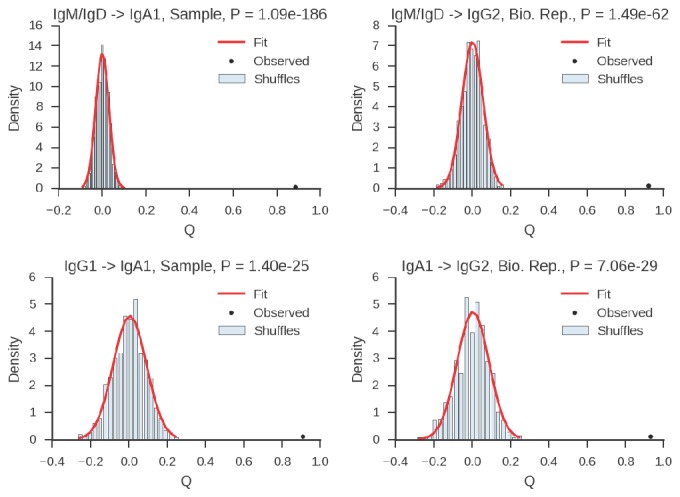
Estimation of significance of correlations between class switch fates of related sequences.Plots show examples of distributions of Yule’s Q for unrelated sequence pairs obtained by shuffling with 1000 replicates, together with fitted Gaussian distribution and observed value of Yule’s Q for the most closely related cells (2 or fewer mutations from common progenitor) for comparison. We calculated the exact one-sided p value of the observed value of Yule’s Q as the probability of the Gaussian random variable taking a value greater than or equal to the observed value of Q.